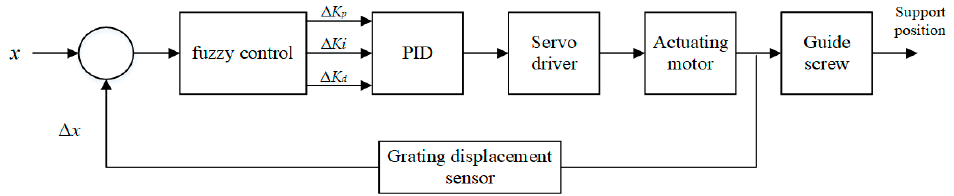
Figure 7. Constant force control principle based on fuzzy PID.